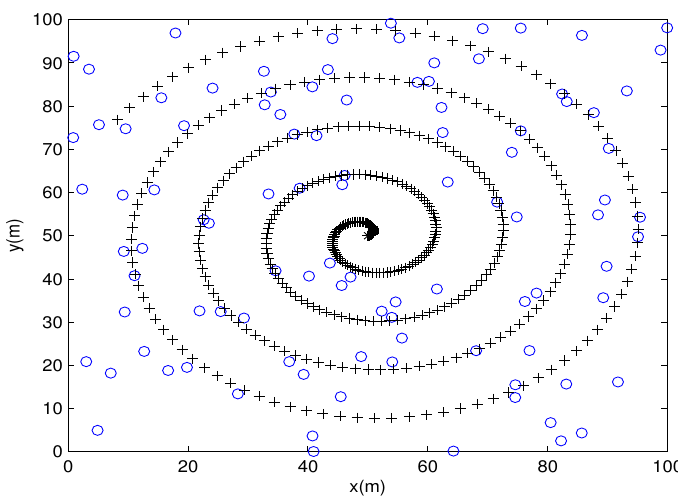
Figure 2. Network design executing spiral